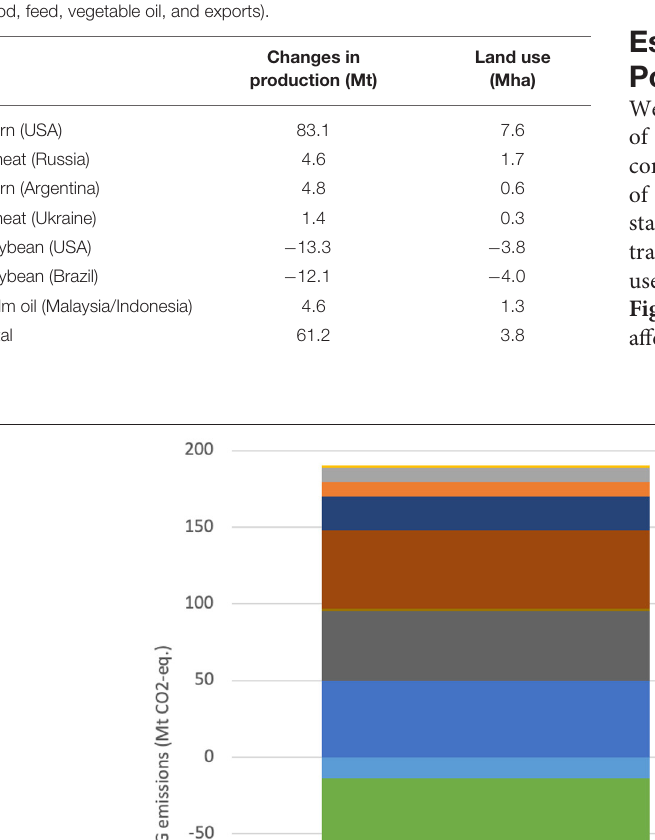
Frontiers in Climate |